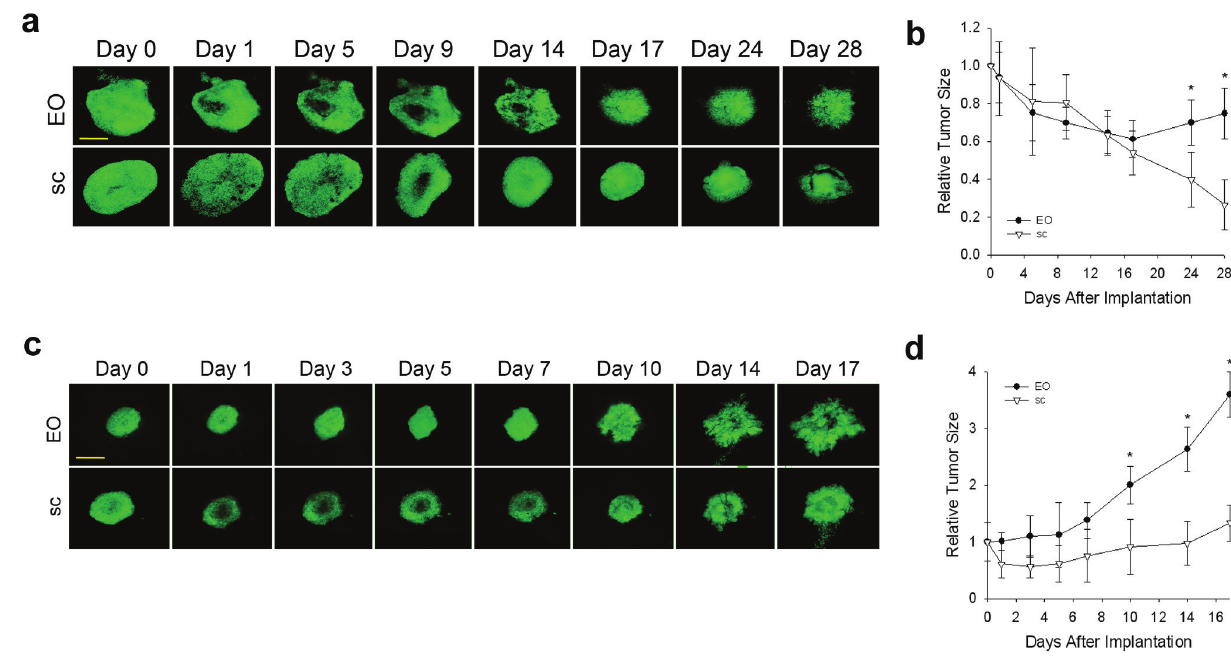
Figure 4. Effect of mouse orthotopic tissue co-engraftment on human BT474 tumor growth. BT474 tumor spheroids expressing H2B- GFP were implanted directly onto the dorsal skin (sc) ( a and b ) or with mouse mammary fat pad donor tissue (EO) ( c and d ) and monitored by IVM. ( a and c ) Fluorescence IVM images on the indicated days after implantation. ( b and d ) Relative tumor growth curves. Tumor size was measured on indicated days based on total GFP fluorescence signal relative to day 1 as in Figure 1. Mice received human estrogen supplement in ( c and d ) but not ( a and b ). Scale bar = 500 μm. n = 3–4 mice for all